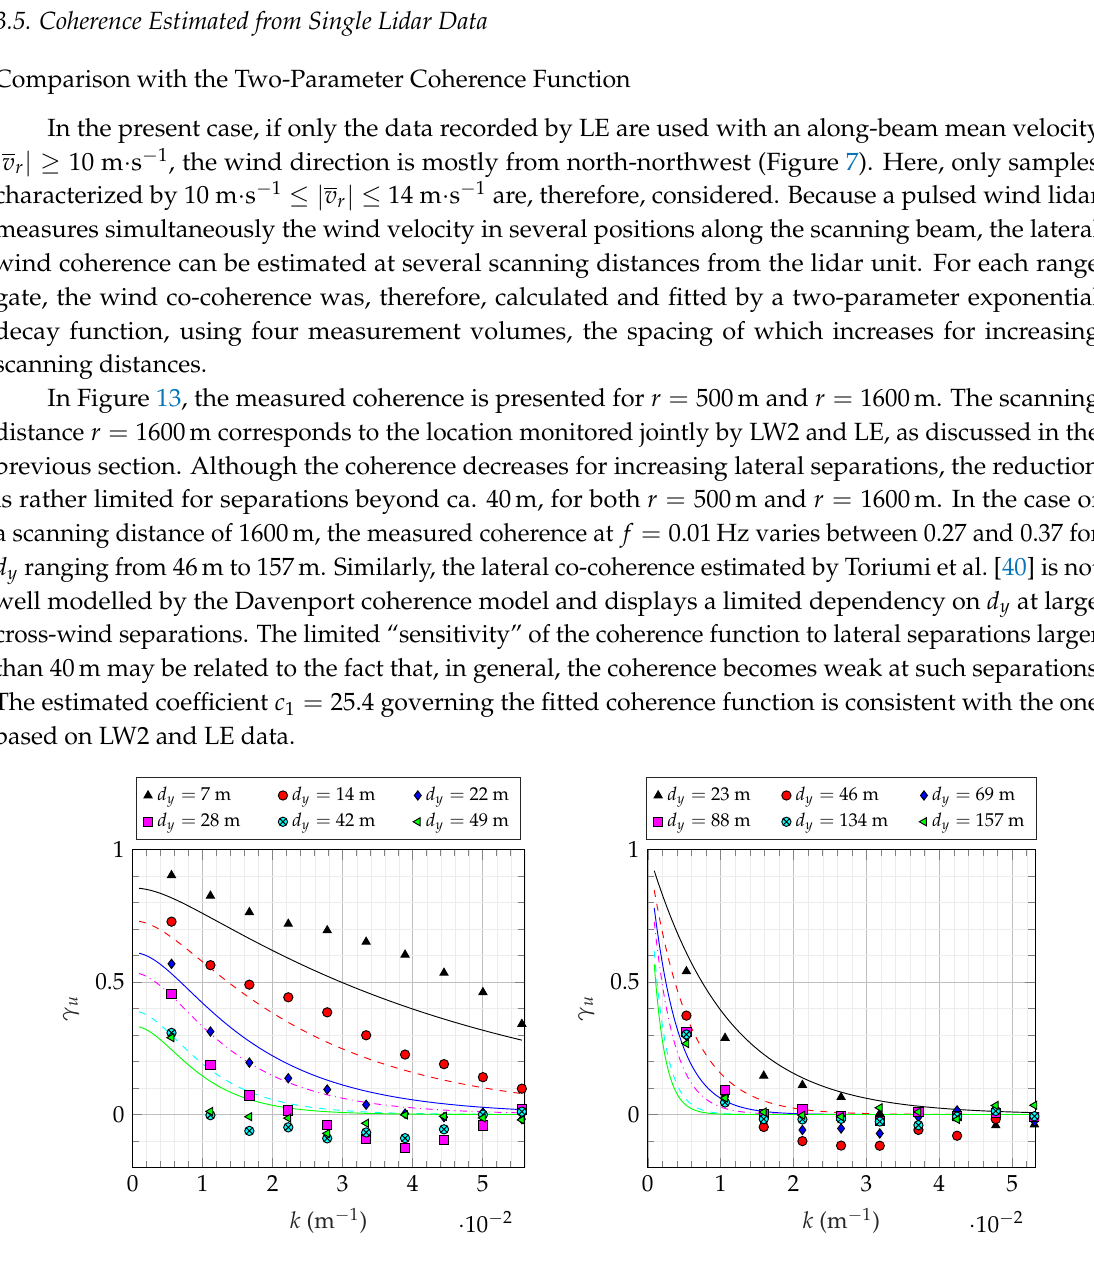
s − 1 14 m s − 1 , v r · ≤ | · | ≤